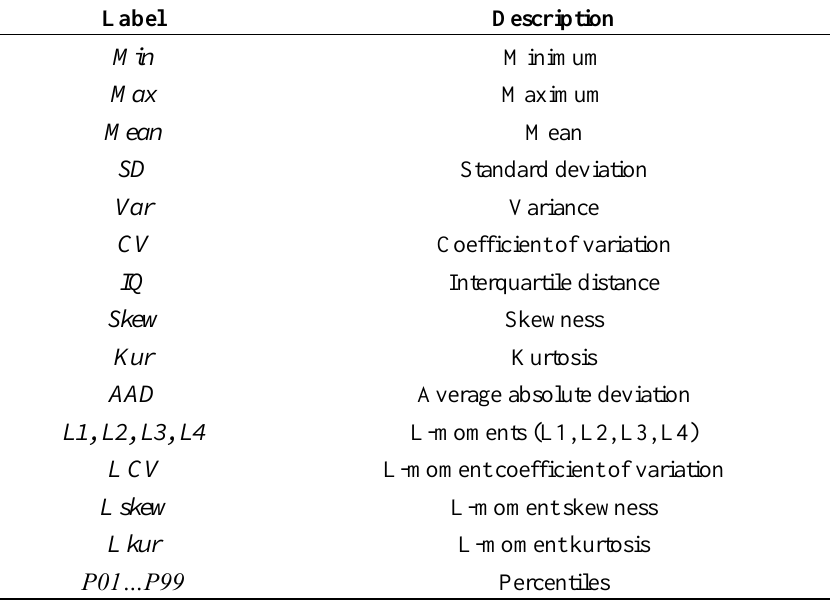
Table 3. Metrics derived from DAI and ALS